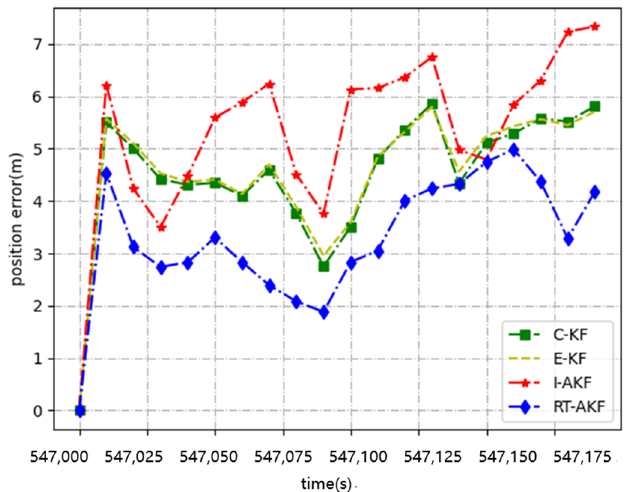
Figure 18. The positioning errors of GNSS/INS tightly coupled integrated by different methods in segment #6.